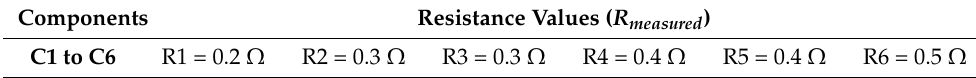
Table 4. Average resistance values of the assembled resistors before OVM.